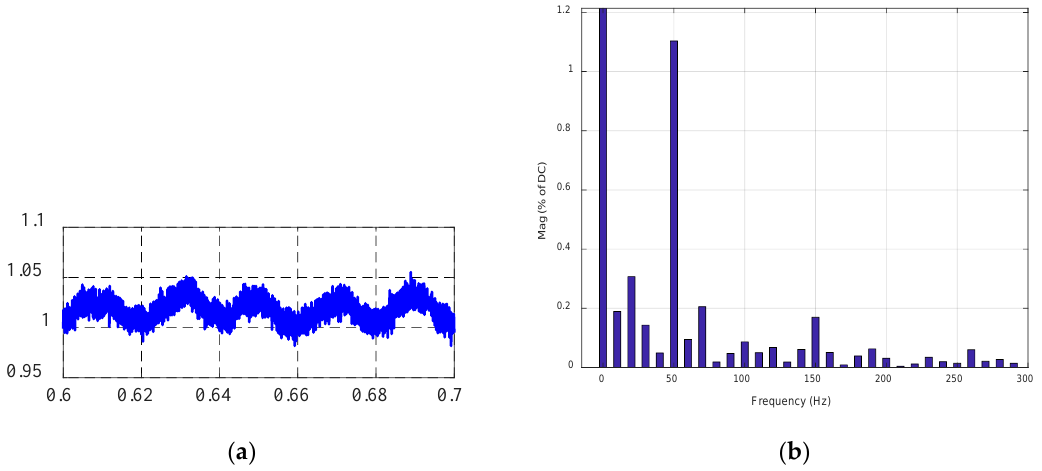
Figure A1. Additional simulation waveforms. ( a ) Zoomed version of dc-link current displayed in Figure 8a, ( b ) FFT spectrum.